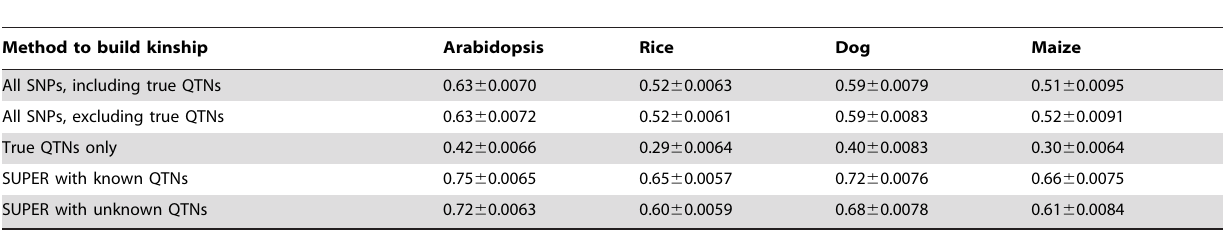
Table 1. Statistical power of using different kinship for four species ( Arabidopsis , Rice, Dog and Maize).